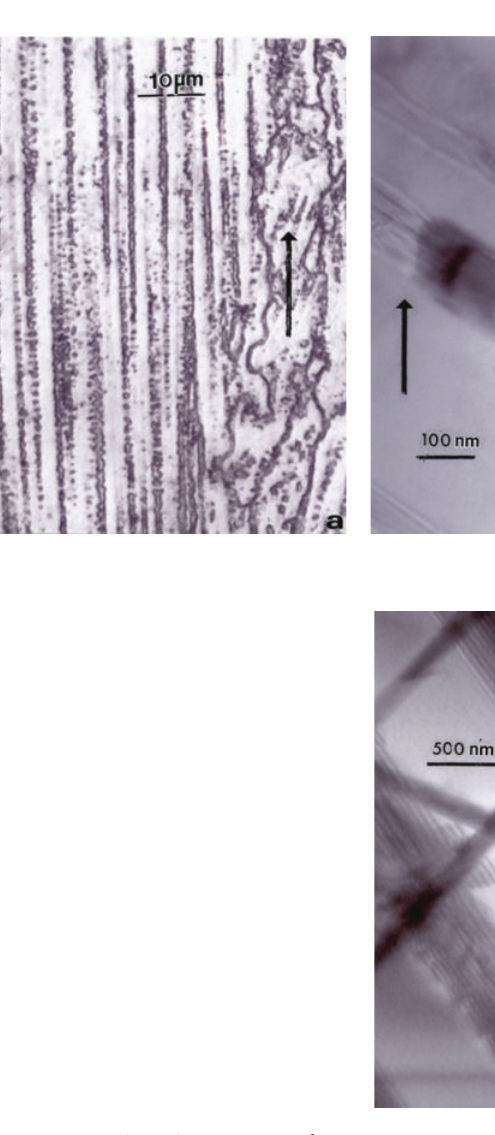
Figure 7: Comparative microstructures for Co-29Cr-6Mo components. (a) Optical micrograph showing columns of Cr 23 C 6 precipitates in the build direction (arrow). (b) TEM image of Cr 23 C 6 precipitate columns in (a). (c) Optical micrograph showing HIP-annealed grain structure. (d) TEM image for intrinsic stacking faults in